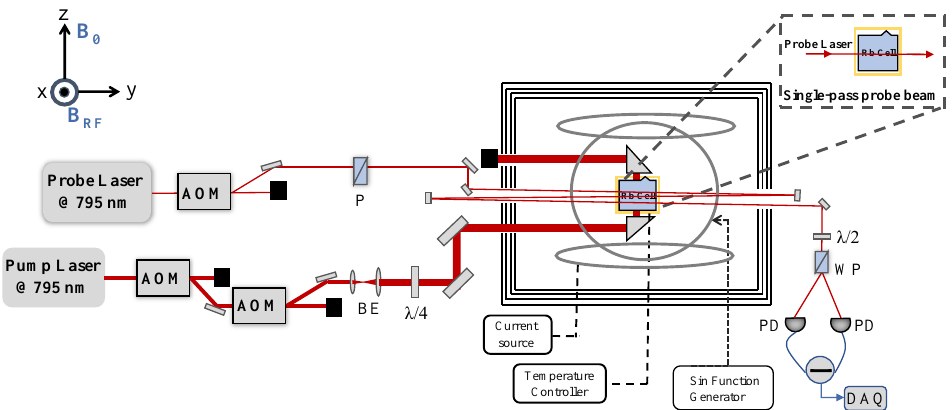
Figure 1. Experimental setup. AOM: acoustic-optical modulator; BE: beam expander; λ /4: quarter-wave plate; λ /2: half-wave plate; P: polarizer; WP: Wollaston prism; PD: photoelectric detector; DAQ: data